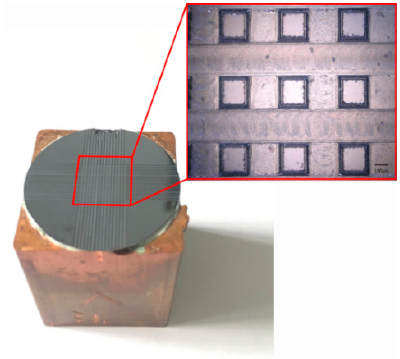
( b ) Figure 4. The schematics of the simulation model: ( a ) initial model and ( b ) model after simulation. ( a ) ( b ) Figure 5. Density profile of a water droplet: ( a ) initial model and ( b ) model after simulation. 4. Results and Discussion According to multiple measurements, the average contact angle of the unprocessed